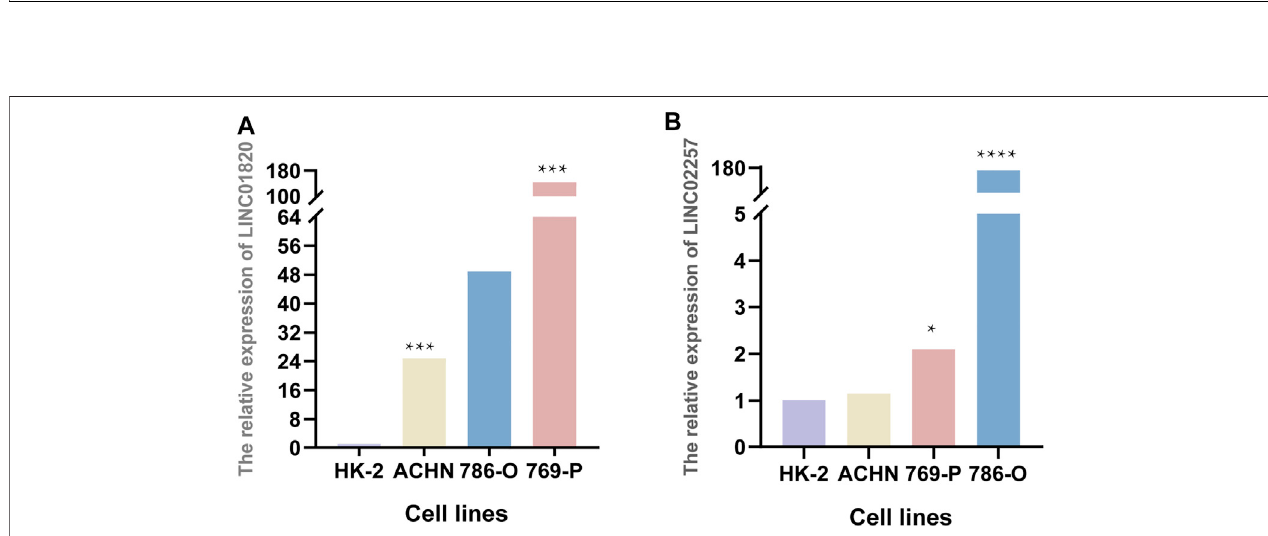
FIGURE 9 | Quantitative analysis for LINC01820 and LINC02257. (A,B) The expression levels of LINC01820 and LINC02257 in HK-2, ACHN, 786-O, and 769-P cell lines. * p < 0.05, *** p < 0.001, **** p < 0.0001.